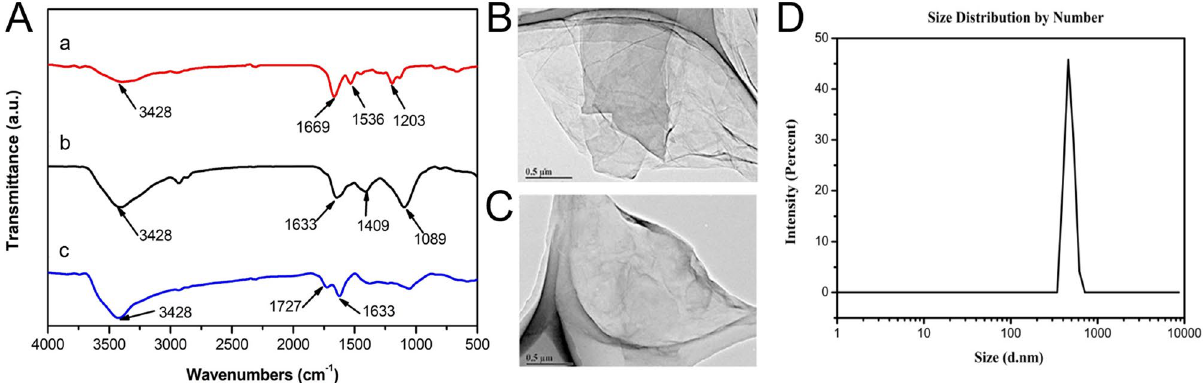
Figure 3. ( A ) Fourier-transform infrared spectroscopy of AF750-6Ahx-Sta-BBN (a), NGO-COOH (b) and NGO-BBN-AF750 (c). TEM of ( B ) NGO-COOH and ( C ) NGO-BBN-AF750. ( D ) Hydrodynamic diameter distribution of NGO-BBN-AF750 determined using dynamic light scattering (DLS).